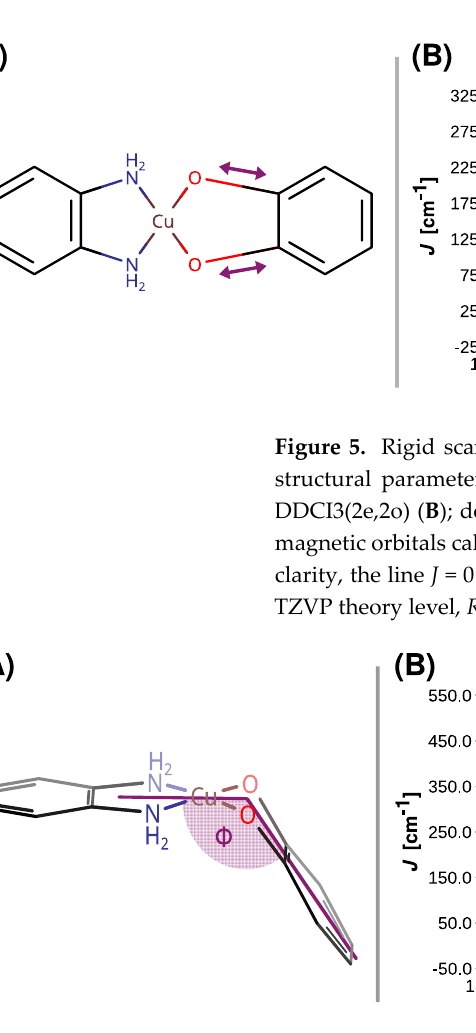
Figure 6. Rigid scan of J along the bending angle between the N-Cu-N and O-Cu-O planes ( Φ ): schematic representation of the varied structural parameter ( A ); the parameter J predicted at the B3LYP and DDCI3(2e,2o) levels ( B ); decomposition of J at the B3LYP level ( C ). Inset in ( B ) shows the overlap of the magnetic orbitals calculated at the B3LYP level. All are calculated with the def2-TZVP basis set. For clarity, the line J = 0 cm − 1 is shown as a reference. For the geometry optimized at the B3LYP/def2-TZVP theory level Φ = 0° (labeled with the yellow symbols).